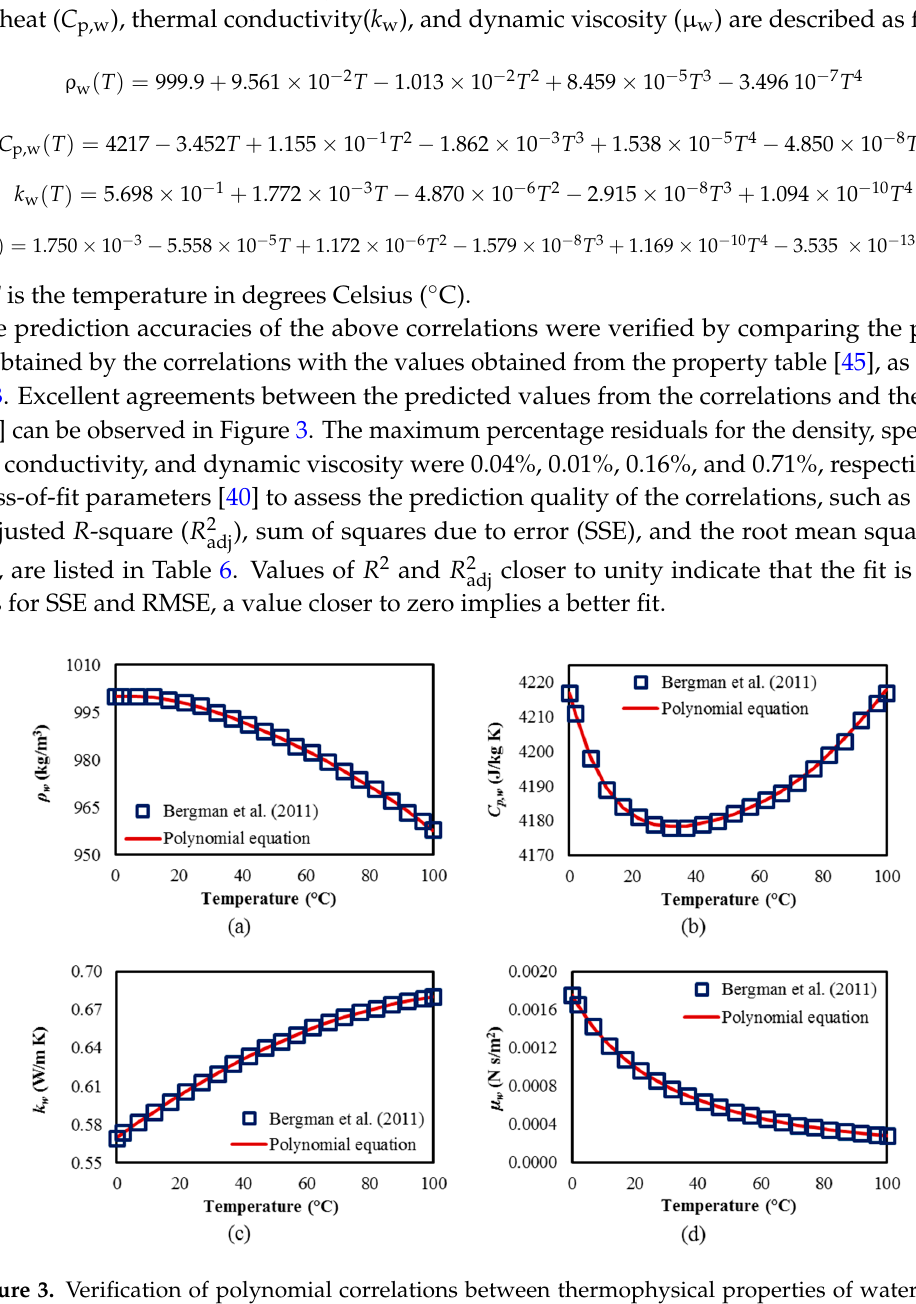
Figure 3. Verification of polynomial correlations between thermophysical properties of water and temperature with the property data from Bergman et al. [45]: ( a ) density ( ρ (cid:2933) ); ( b ) specific heat ( (cid:1829) (cid:2926),(cid:2933) ); ( c ) thermal conductivity ( k w ); and ( d ) dynamic viscosity ( µ w ). ( c ) thermal conductivity ( (cid:1863) (cid:2933) ); and ( d ) dynamic viscosity ( μ (cid:2933) ). Table 6. Goodness-of-fit parameters for the temperature-dependent property correlations. Table 6. Goodness-of-fit parameters for the temperature-dependent property